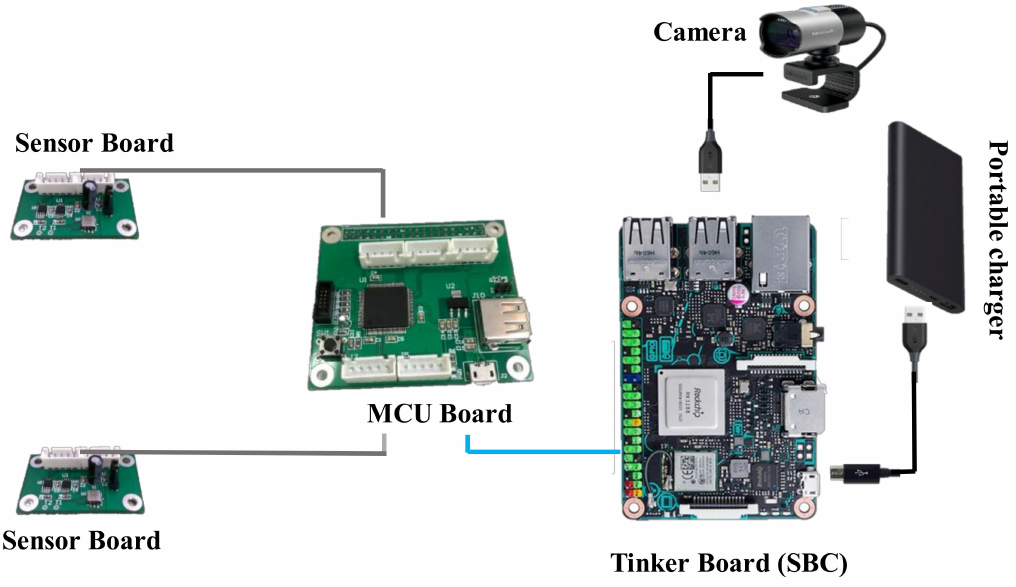
Figure 1. The prototype of the smart camera system.